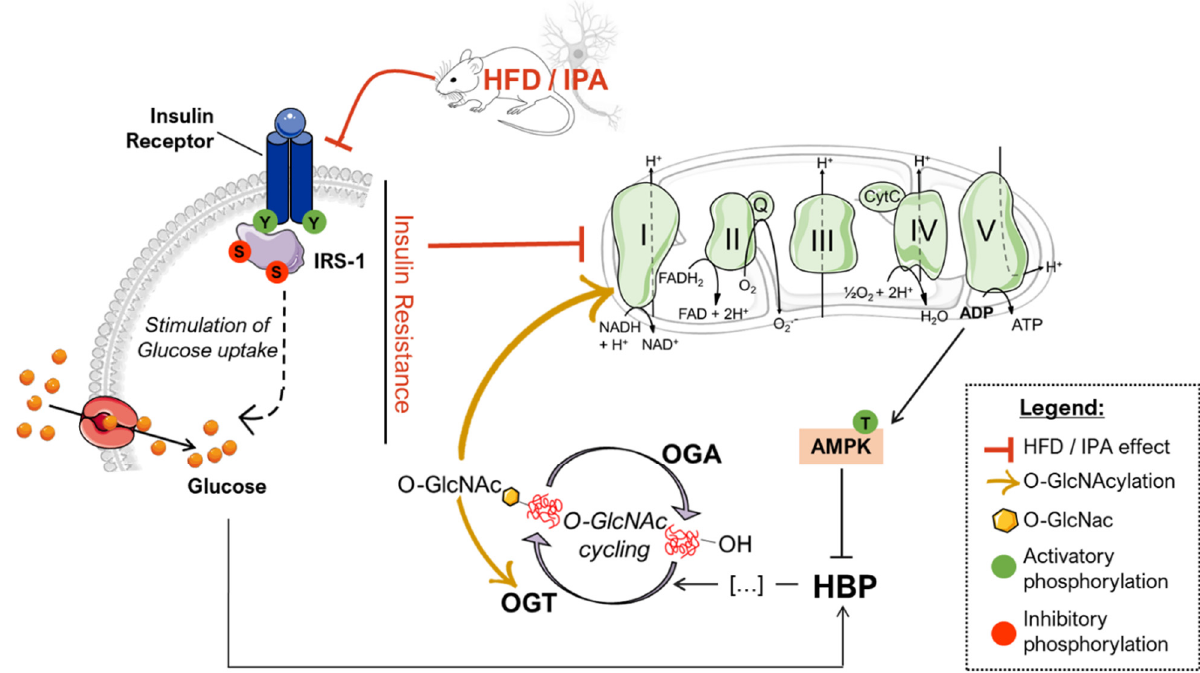
Figure 9. Proposed scenario of the altered mechanisms driven by HFD/IPA treatment. According to our data, nutrient overload results in defective insulin signaling both in HFD mice and IPA-treated SHSY-5Y cells, which translate into reduced glycolytic and mitochondrial metabolism. In turn, mitochondrial defects are responsible for impaired bioenergetic and increased ADP/ATP ratios that activate AMPK, a key GFAT1 inhibitor, leading to the reduced entrance of nutrients into the hexosamine biosynthetic pathway (HBP). GFAT1 inhibition, together with insulin resistance-driven nutrient deprivation, is responsible for the impairment of the HBP flux and the consequent reduction of the overall levels of O-GlcNAcylated proteins. The disruption of O-GlcNAc homeostasis is associated with altered OGT PTMs that could further exacerbate the efficiency of O-GlcNAc cycling. In addition, the reduction of Complex I-specific O-GlcNAcylation may represent a key aspect involved in exacerbating the alterations mitochondrial energetic profile.